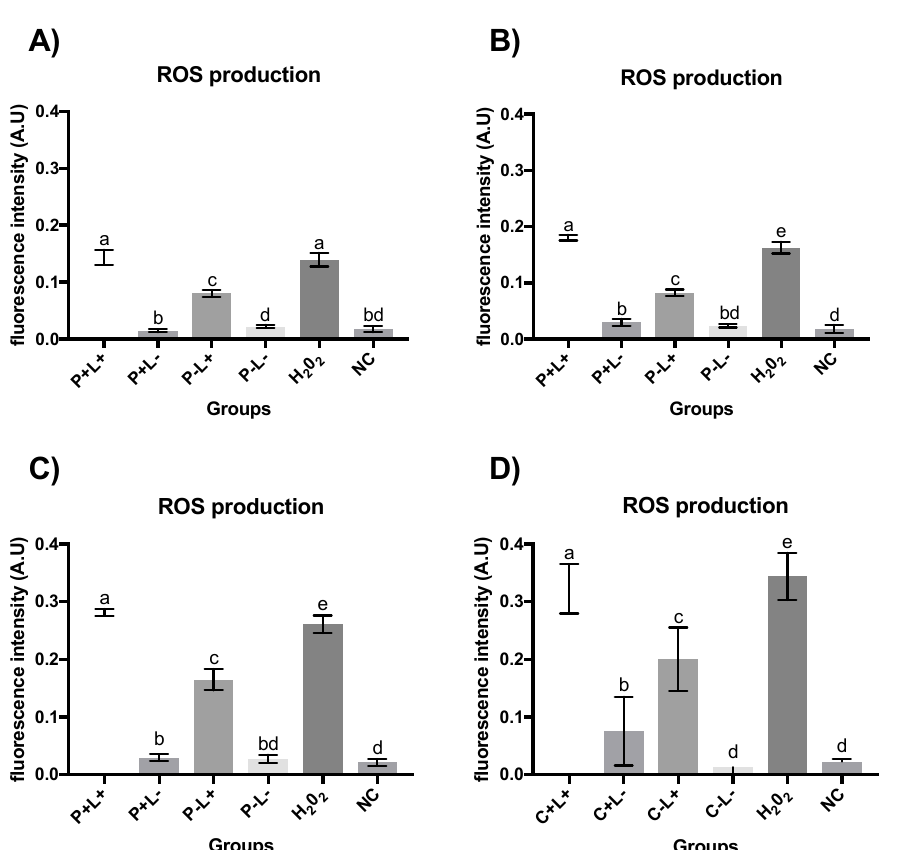
Figure 10. Graphic representation of the mean values and standard deviation of ROS production, measured as fluorescence intensity by fluorometric H2DCF-DA oxidation, of C. albicans suspensions ( A , B ) and biofilm ( C , D ) after the first application ( A , C ) and seventh application ( B , D ), subjected to aPDT (P+L+), PDZ (P+L − ), light only (P − L+), no treatment (P − L − ), hydrogen peroxide (H 2 O 2 ), and negative control group with cells treated in no fluorochrome (NC). A.U.—arbitrary units. Different letters (a; b; c; d; e) denote statistical differences between columns (groups) according to the Games– Howell post-test ( p < 0.05) ( n = 12). The ROS intracellular production performed after Apl#1 application of aPDT mediated by CUR in planktonic cultures of C. albicans (Figure 11A) showed that the C+L+ group was statistically different from the other experimental groups. However, the C − L+ group was statistically similar to the H 2 O 2 group. In addition, the groups C+L − , C − L − , and NC showed the lowest levels of ROS. After Apl#3 application of aPDT (Figure 11B), the C − L+ group was similar to the H 2 O 2 group. After Apl#1 of aPDT mediated by CUR in biofilm (Figure 11C), the highest values of intracellular ROS (mean of 0.28 A.U.) were observed for the H 2 O 2 group (H 2 O 2 ). In addition, the C+L+ group presented intermediate values (mean of 0.20 A.U.). The C+L − group showed statistically similar values to the C − L+ group. The experimental control group (C − L − ) and negative control (NC) also behaved similarly. After Apl#10 of C+L+ in biofilm (Figure 11D), similar to that observed after Apl#1, the H 2 O 2 group showed the highest production of intracellular ROS (mean of 0.36